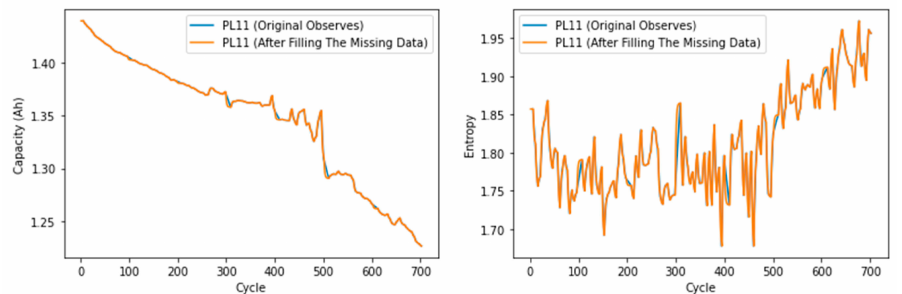
Figure 4. Capacity vs. Cycle ( left ) and Entropy vs. Cycle ( right ) for PL11.